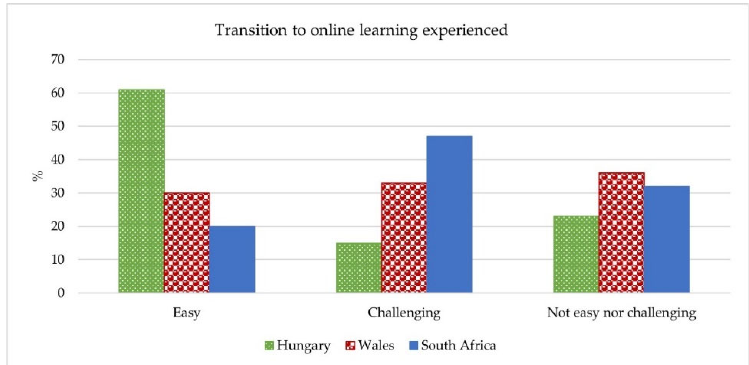
Figure 19. Perceived ease of transition to online learning (%).